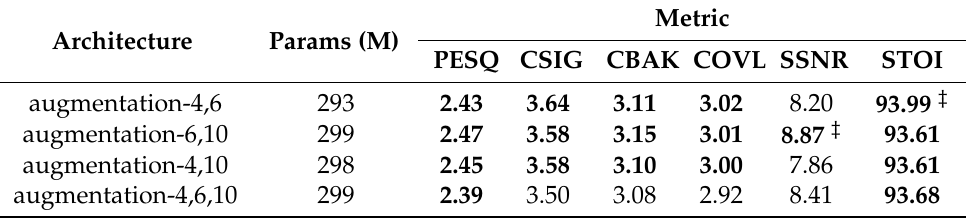
Table 3. Performance of the attention augmented convolutional SEGAN. We denote the proposed architecture where the self-attention couples the l th (de)convolutional layer(s) as augmentation-l . Values that overtake all baseline systems are in bold. Values with an ‡ are the ones that overtake their best counterparts on the same metric in Tables 1 and